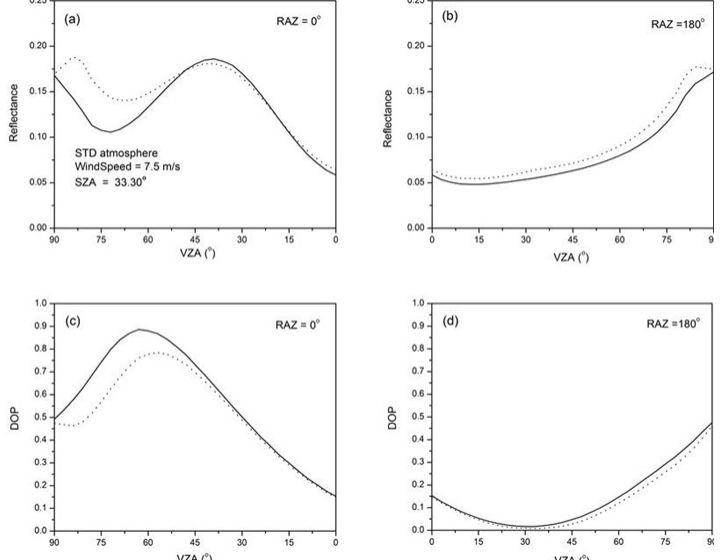
Fig. 18. The total reflectance and DOP on the principal plane, which is calculated with the ADRTM at the wavelengths of 550nm from the ocean–atmosphere system without aerosols (solid curve) and with sea salt aerosols (dashed curve) of optical thickness 0.1. The ocean wind speed is 7.5ms − 1 . The SZA is 33.30 ◦ . The US STD atmosphere is used.